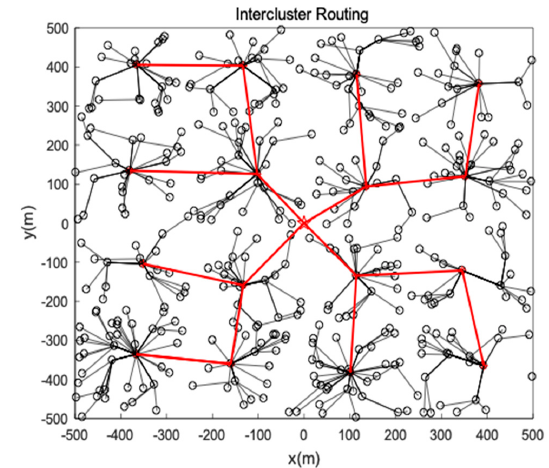
Figure 7. Intercluster routing.